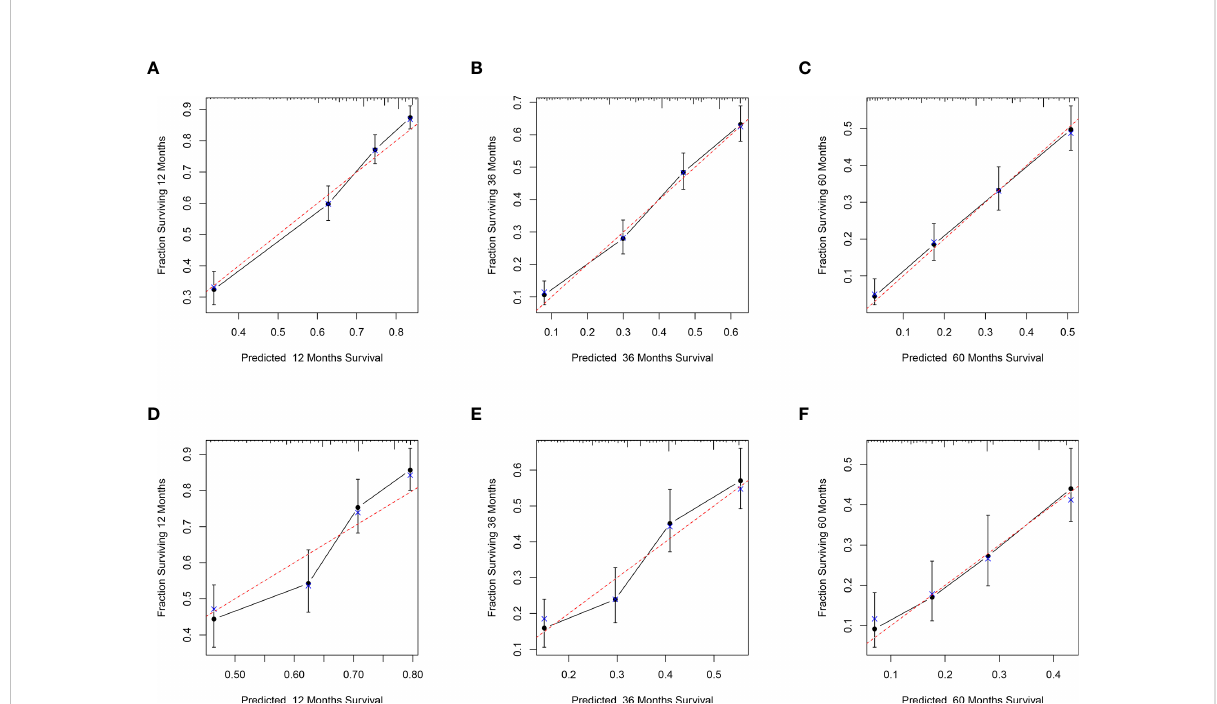
FIGURE 4 Calibration plots for the nomogram. Calibration plots of 1-year (A) , 3-year (B) , and 5-year (C) CSS in the training set; Calibration plots of 1-year (D) , 3-year (E) , and 5-year (F) CSS in the validation set. CSS, Cancer-Speci fi c